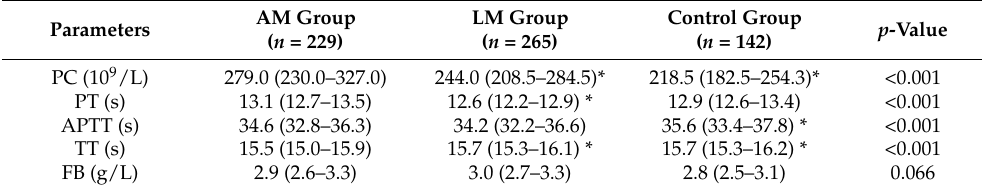
Table 2. Comparisons of coagulation parameters between groups.